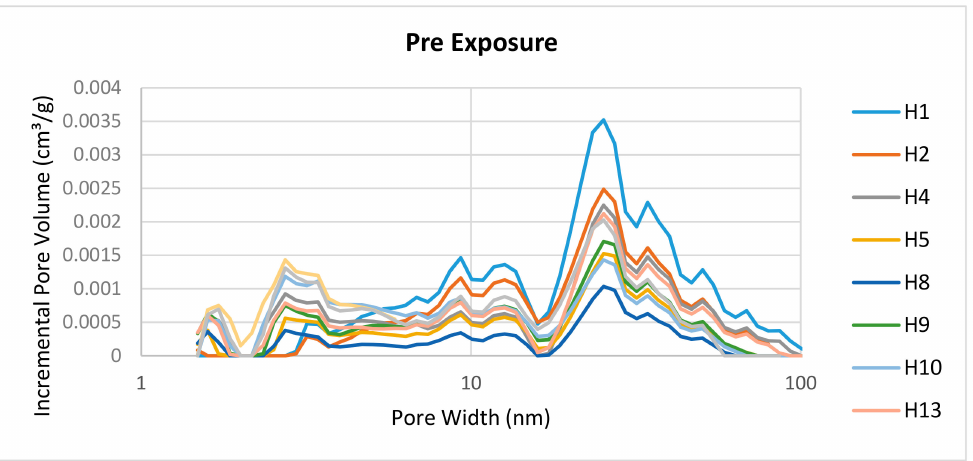
Figure 8. Pore size distributions for the samples analysed before exposure to scCO 2